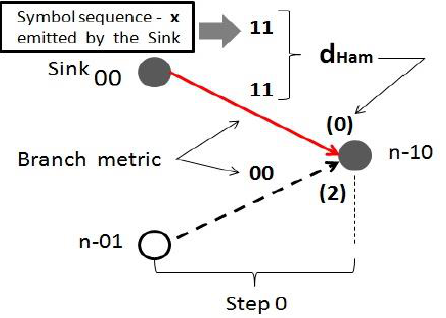
Figure 4. (a) MM - generator with the input sequence k n (t) and output word code out n (t) = (c 1 , c 2 ) ; (b) Tree diagram based on the MM - generator and detail of the path in the "full line" onthe tree, associated to the input sequence kn (t) in the generating MM; (c) Trellis diagram.